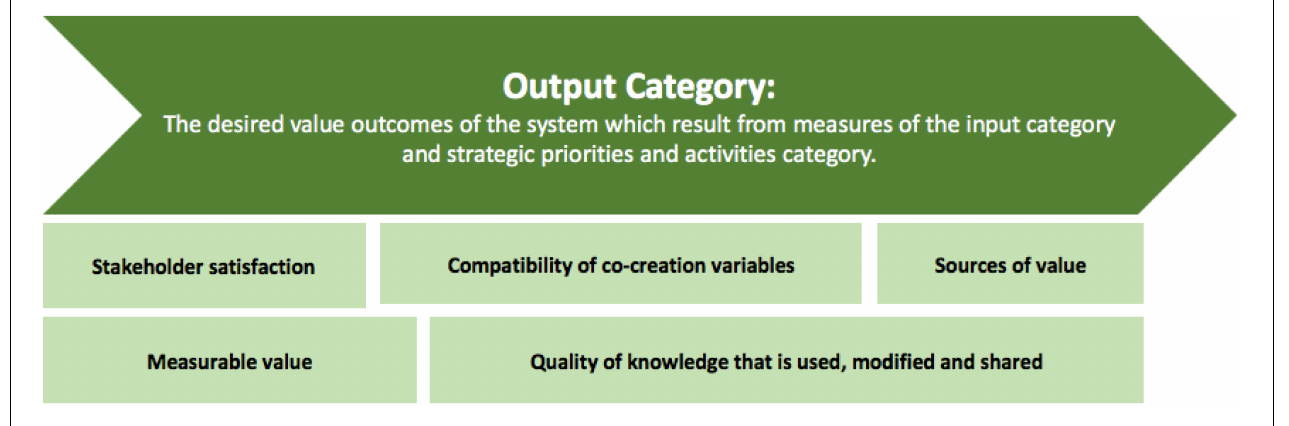
FIGURE 15 | Recommended value outcomes to be